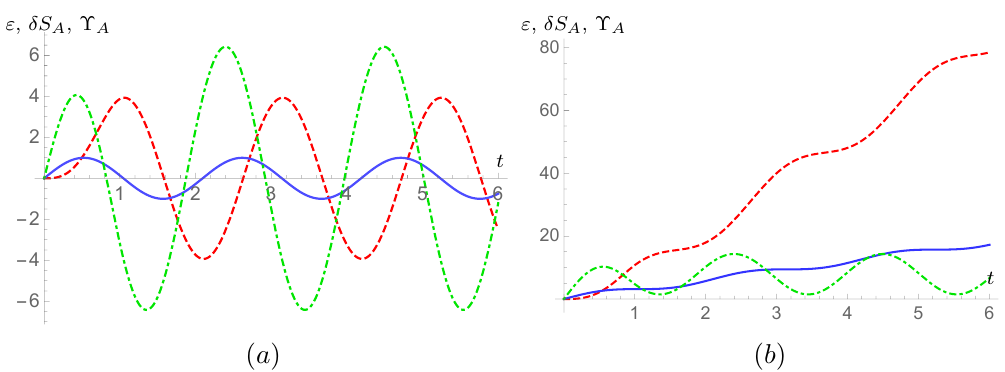
Figure 7 . Sample plots for the source " ( t ) (solid blue) entanglement entropy (cid:14)S and relative entropy (cid:7) A ( t ) (dot-dashed green) for a ball-shaped region in d = 3 dimensions. For the plots we have chosen the following parameters: " 0 = 1, t periodic source and ( b ) a source respecting the bulk NEC with (cid:16) =